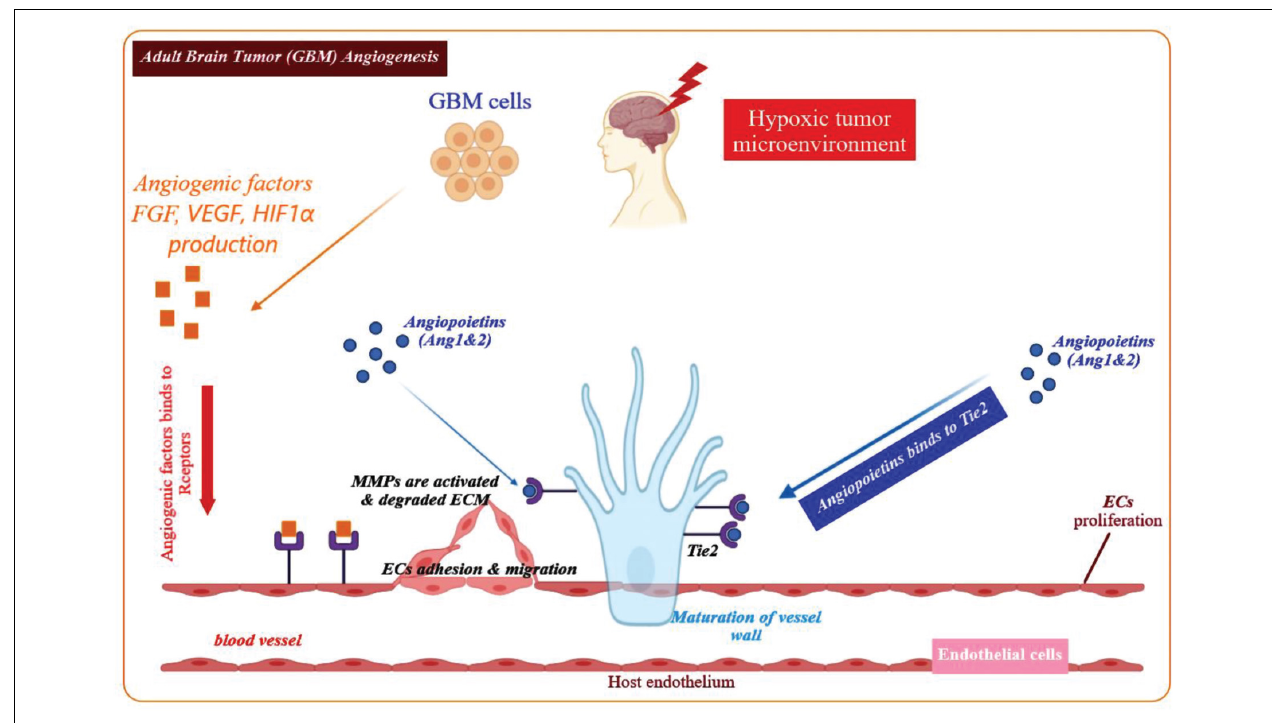
FIGURE 1 | Overview of the angiogenic process in GBM. Angiogenesis is initiated by angiogenic factors released from the GBM cells in the microenvironment of a hypoxic tumor. Key angiogenic factors contributing to the GBM angiogenesis process include, FGF, VEGF, Ang-1, Ang-2, and HIF1 α . These factors bind to their respective receptors on the endothelial cells and stimulate migration and proliferation of the endothelial cells. The ECM is gradually degraded and in the next phase, the endothelial cells assemble into a tube or vessel-like structure. It is notable that maturation of the blood vessel walls is accompanied by recruitment of pericytes that cover the endothelial cells from the outer surface, in order to construct a new functional blood